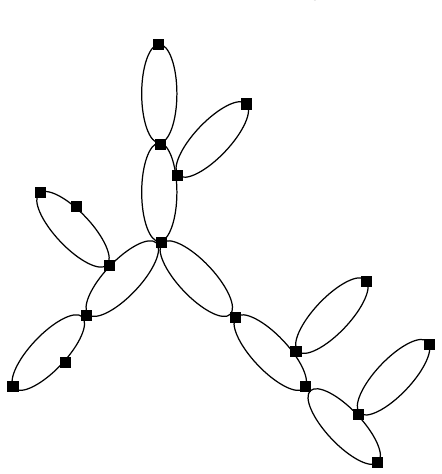
Figure 6 . A non-1PI graph.